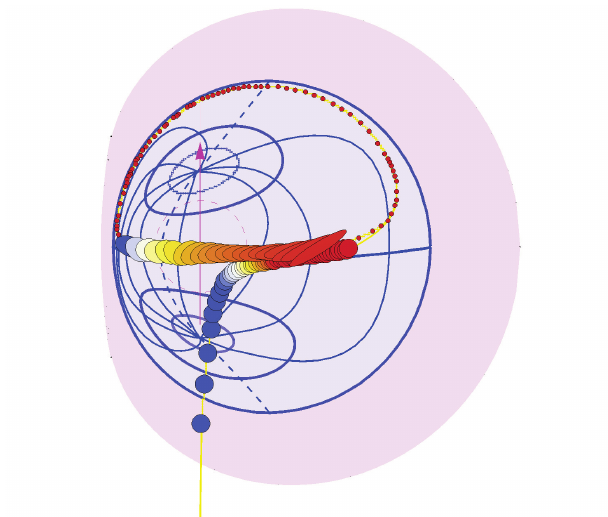
Figure 11. Numerical modeling of the gravitational lensing of the compact star, falling into the fast rotating black hole SgrA* ( a = 0.9982) and observed in discrete time intervals by a distant static observer, placed a little bit above the equatorial plane. The falling star has a zero azimuth angular momentum and moves in the black hole equatorial plane. A yellow curve is a viewed trajectory of this star. The images of this star are projected on the celestial sphere inside the classical black hole shadow (a big closed light purple region), when this star is approaching the black hole event horizon, and then start to multiply winding up around the black hole very near to the black hole equatorial parallel θ = π /2 on the lensed event horizon globe. The first circle of this multiple winding is shown. Brightness of the lensed star exponentially faded in time during successive windings. The closed blue curves are meridians and parallels on the reconstructed image of the lensed event horizon